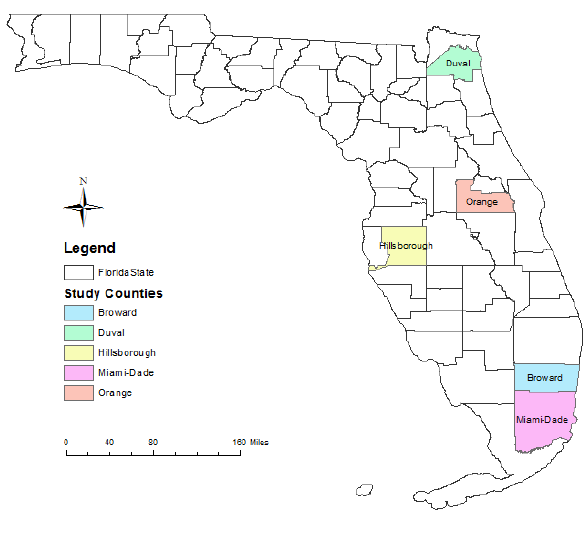
Figure 1. The five selected counties in